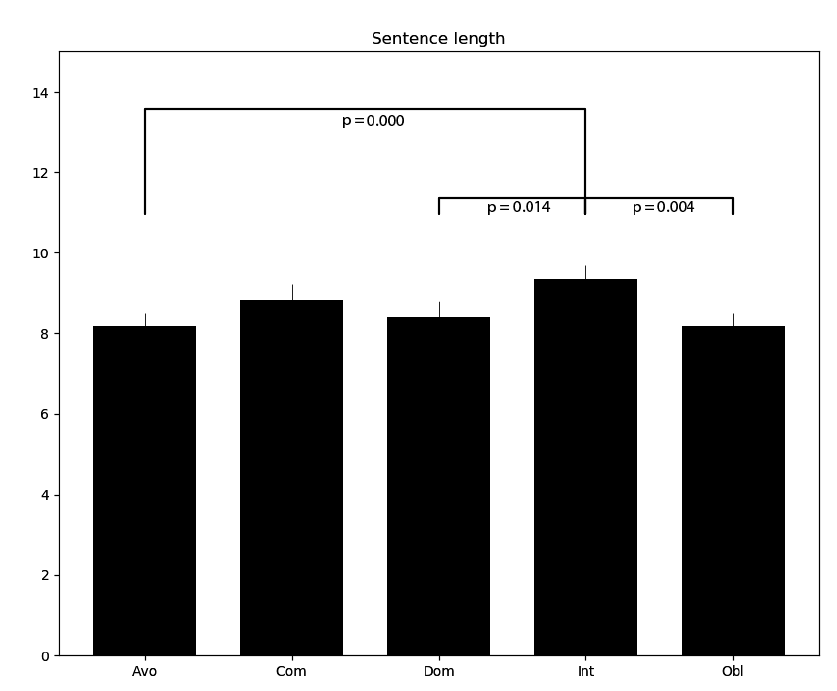
Figure 11. Mean , standard deviations and ANOVA post-hoc analysis of the sentence length among the documents. Significant results are marked and annotated on top with the p